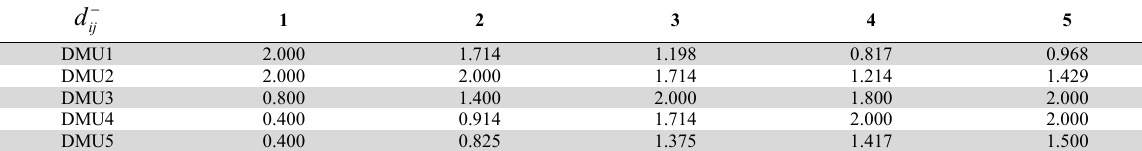
The distance from NIS for alternative i and criterion j for a performance assessment problem d − 1 ij